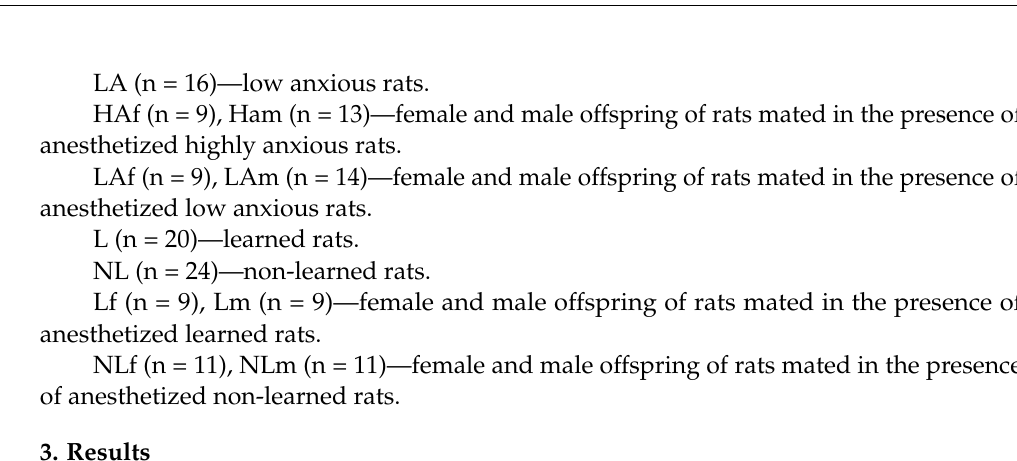
Figure 2. Total horizontal motor activity of female rats for 60 min. * p < 0.05 between ACTf and PASf; # p < 0.05 between ACT1 and ACT2; & p < 0.05 between PAS1 and PAS2.